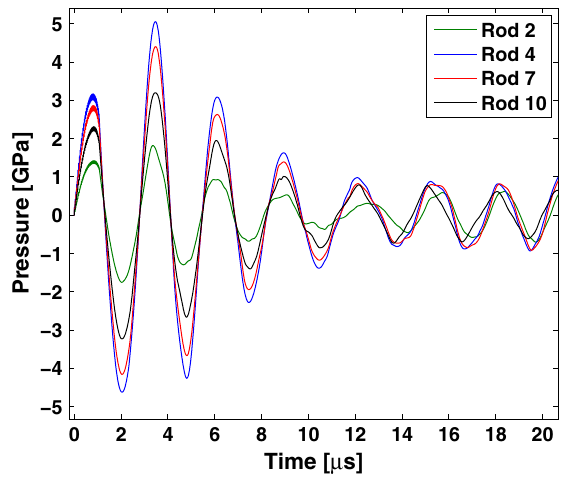
FIG. 5. Picture of the sample holder used in the experiment, which was carrying the crystal samples (irradiated within the experiment HRMT-18), and the HRMT-42 target.